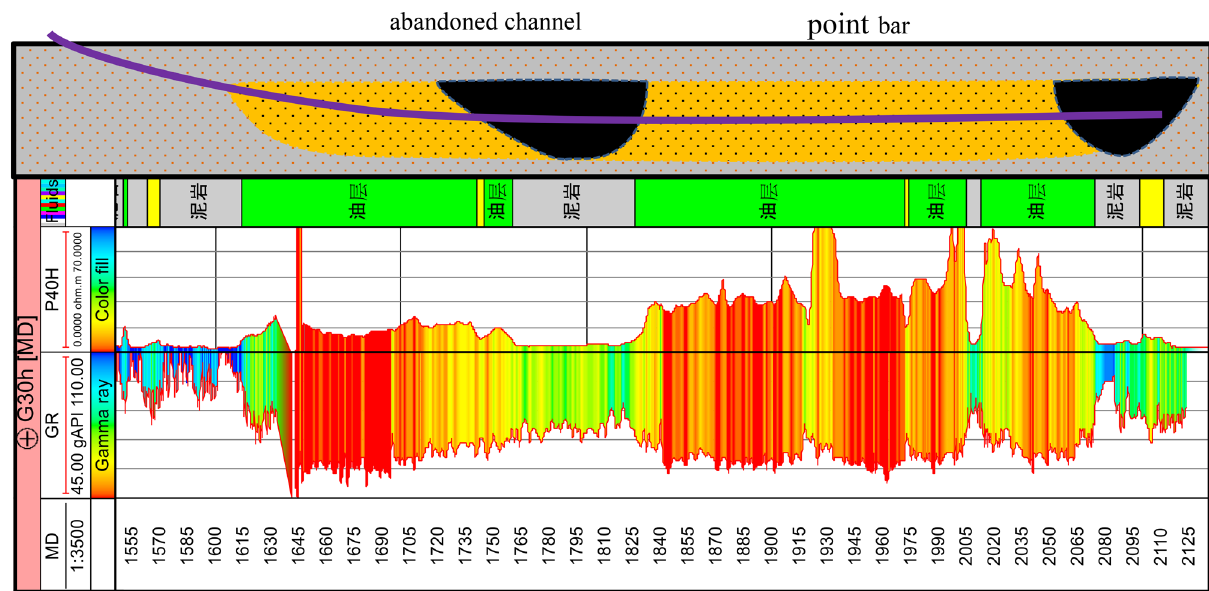
Fig. 2 The GR curve of G30H horizontal